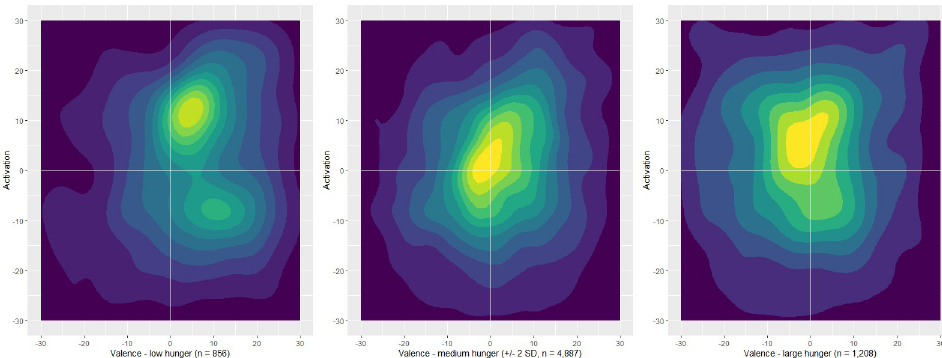
Fig 1. Russell’s affect grid using ipsatised